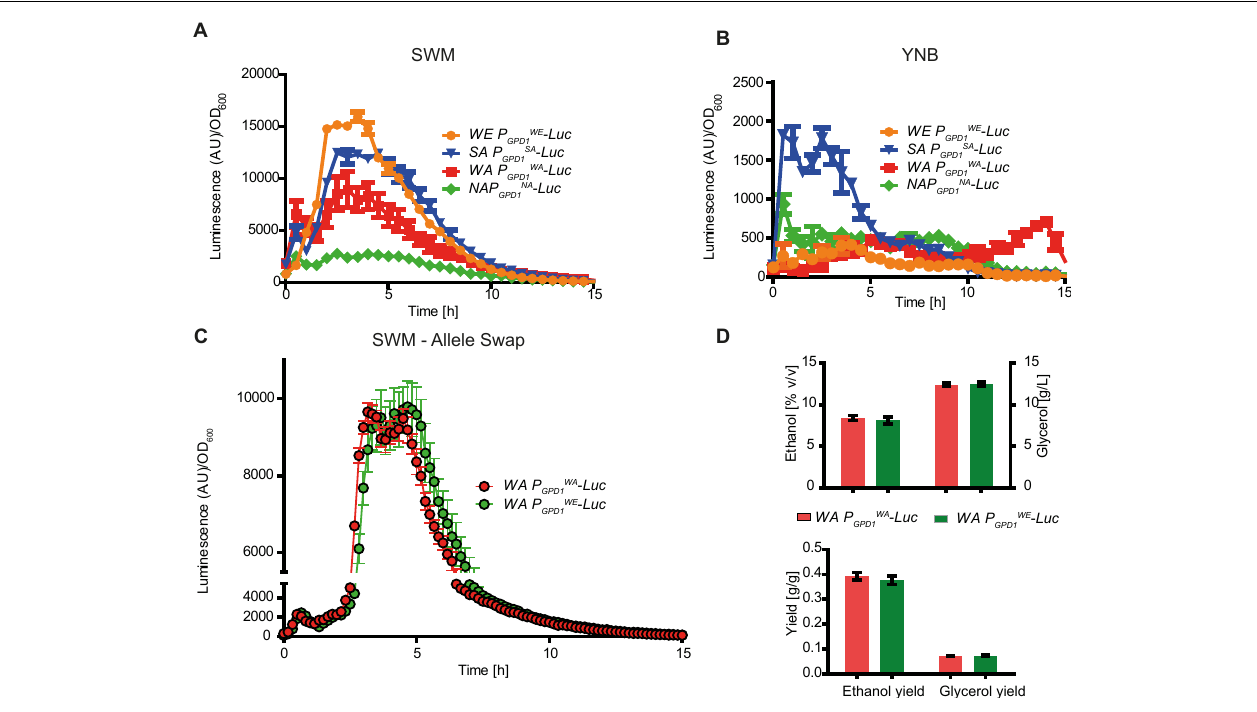
FIGURE 3 | GPD1 gene expression profile. Luciferase reporter gene expression assay for GPD1 promoters in their native genetic backgrounds grown in (A) synthetic wine must and (B) yeast nitrogen base (YNB). (C) Allele swap in the WA strain with a luciferase reporter gene controlled by the wild type promoter (red) and the WE promoter (green). (D) Metabolite levels in the allele swap